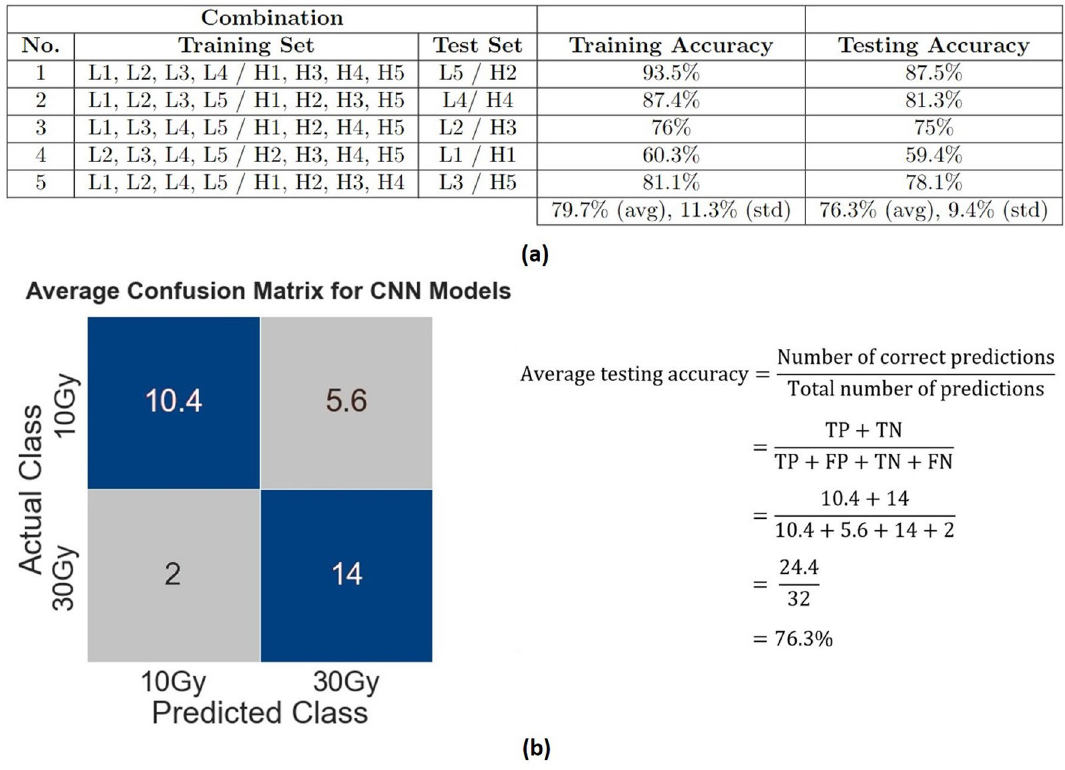
Figure 4. Performance summary of the models in terms of accuracy, and identification of the best model: ( a ) Training and testing accuracy of the 5 separate CNN train-test runs (avg: average, std: standard deviation); ( b ) Average confusion matrix and testing accuracy generated by the five CNN models for the binary low dose vs. high dose classes problem using 200 training image volumes and 32 testing image volumes (as evident from N = 32 summed up over all quadrants of the matrix). Blue quadrants represent the average number of correct predictions (true positives & true negatives) taken from each confusion matrix generated from each of the 5 runs; grey quadrants represent the average number of incorrect predictions (false positives & false negatives). The decimal values in the top two quadrants occur due to the sum of the predictions not being evenly divisible by five, unlike the bottom two which do yield whole numbers. TP: true positives, FP: false positives, TN: true negatives, FN: false